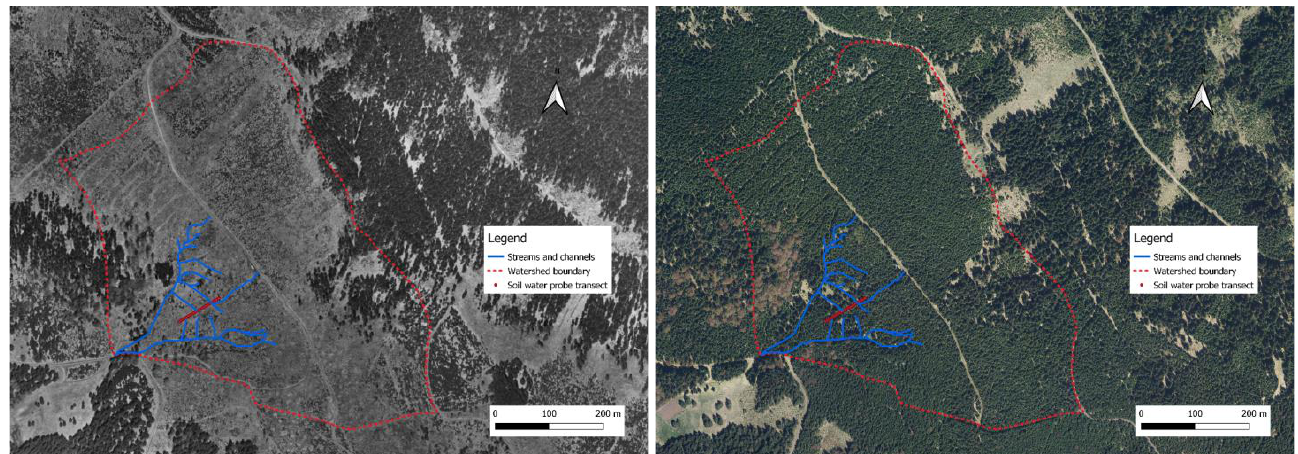
Figure 4. Forest cover restoration on the experimental catchment. Young plantation — age < 9 years; young growth — age between 9 and 20 years; pole-stage stand — age between 21 and 32 (in 2018); the mature spruce stand was 64 years old in 1985; the mature beech stand was 74 years old in 1985.